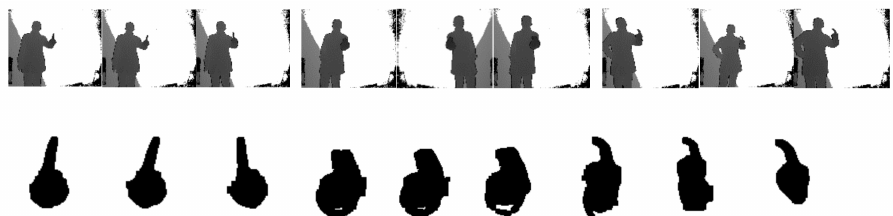
Figure 9. Nine samples from three different types of gestures and extracted hand regions.